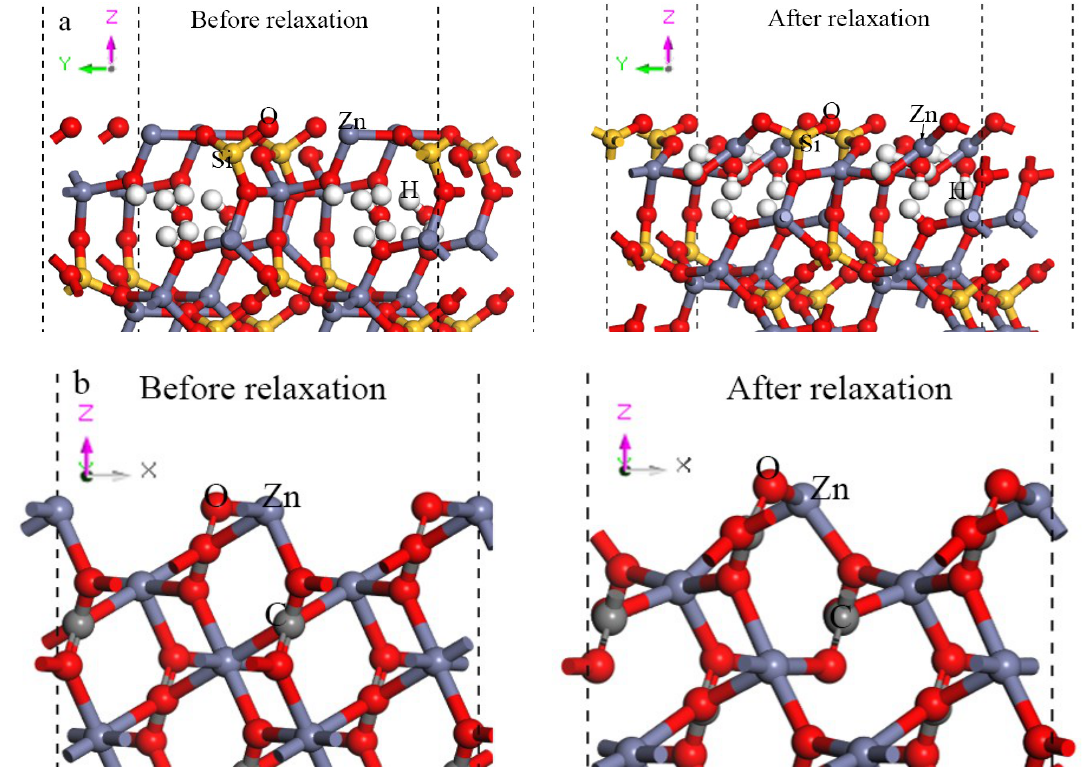
Figure 4. Structures of hemimorphite (110) plane slab model ( a ) and smithsonite (101) plane slab model ( b ) before and after surface atom relaxation.